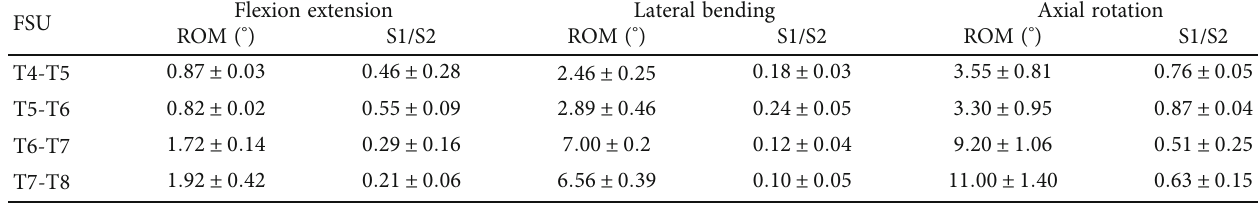
Table 4: Results of the ROM and S1/S2 for each motion of synthetic paediatric specimen at moment of ± 4 Nm.